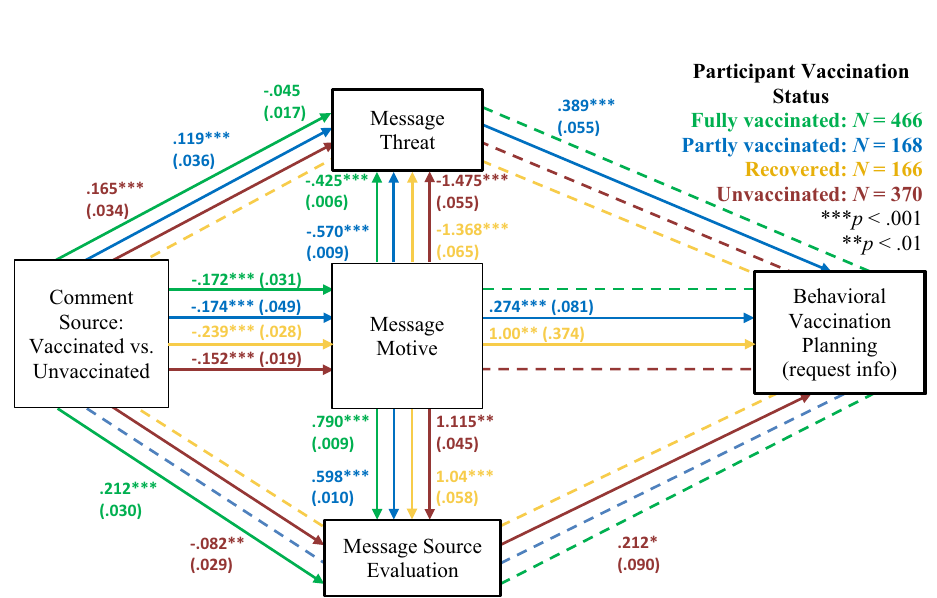
Figure 4. Results of structural equation model analyses on behavioral planning by vaccination status. Dashed lines represent non-significant paths. Estimates are standardized regression coefficients and SEs in parentheses; only significant paths are